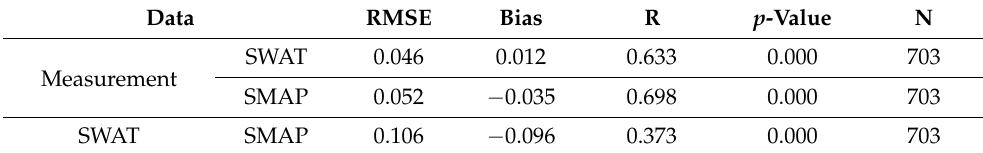
Figure 2. Monthly simulated and observed flows during the calibration period (1995–2004) and validation period (2005–2010). Table 4. Daily calibration of SWAT model with field measurement data and SMAP.